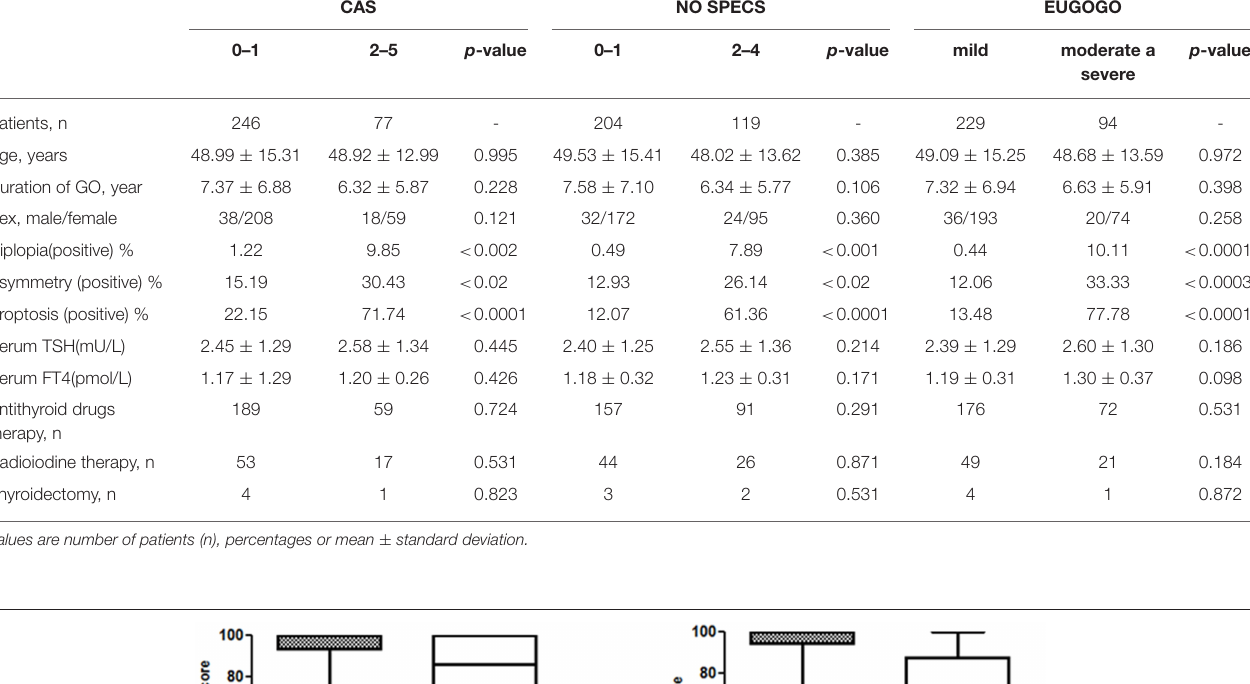
Frontiers in Endocrinology |